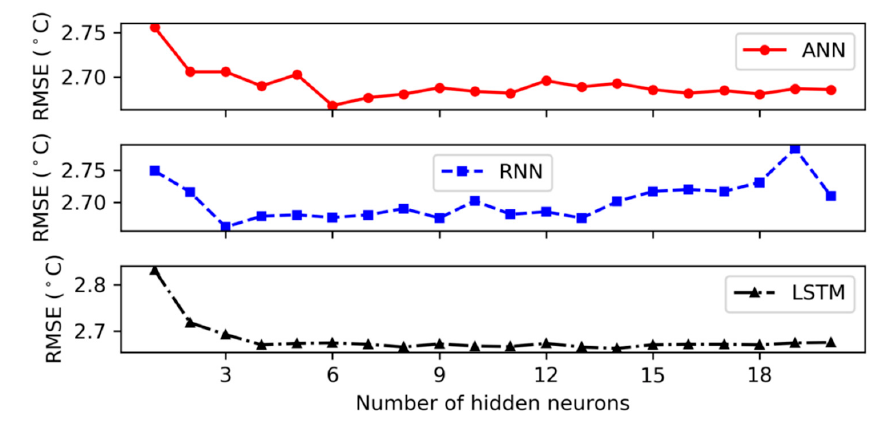
Figure 8. Root mean square error corresponding to different number of hidden neurons for 1 hidden layer in autumn.